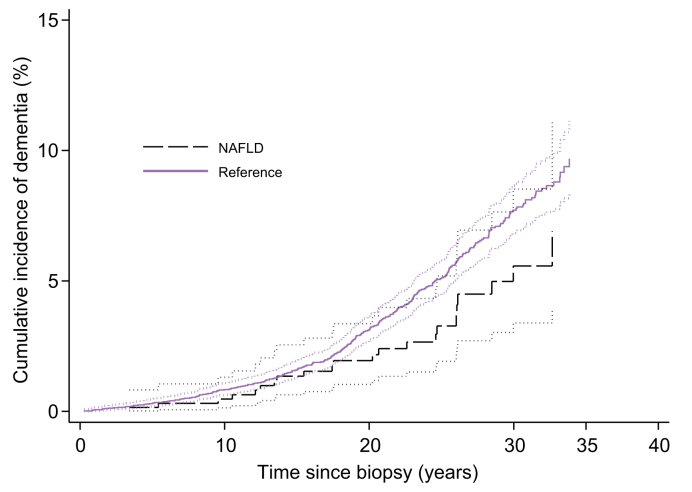
Cumulative incidence of dementia among NAFLD patients and their matched reference individuals from the general population. NAFLD, non-alcoholic fatty liver disease.